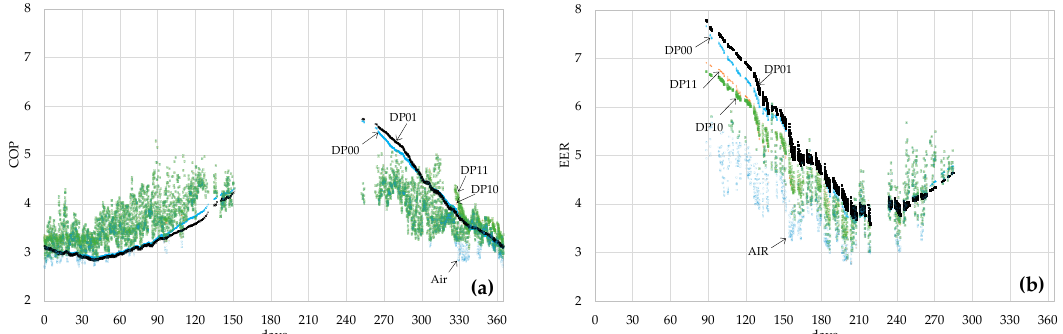
Figure 11. ( a ) Coefficient of performance (COP) and ( b ) energy efficiency ratio (EER) hourly trend.